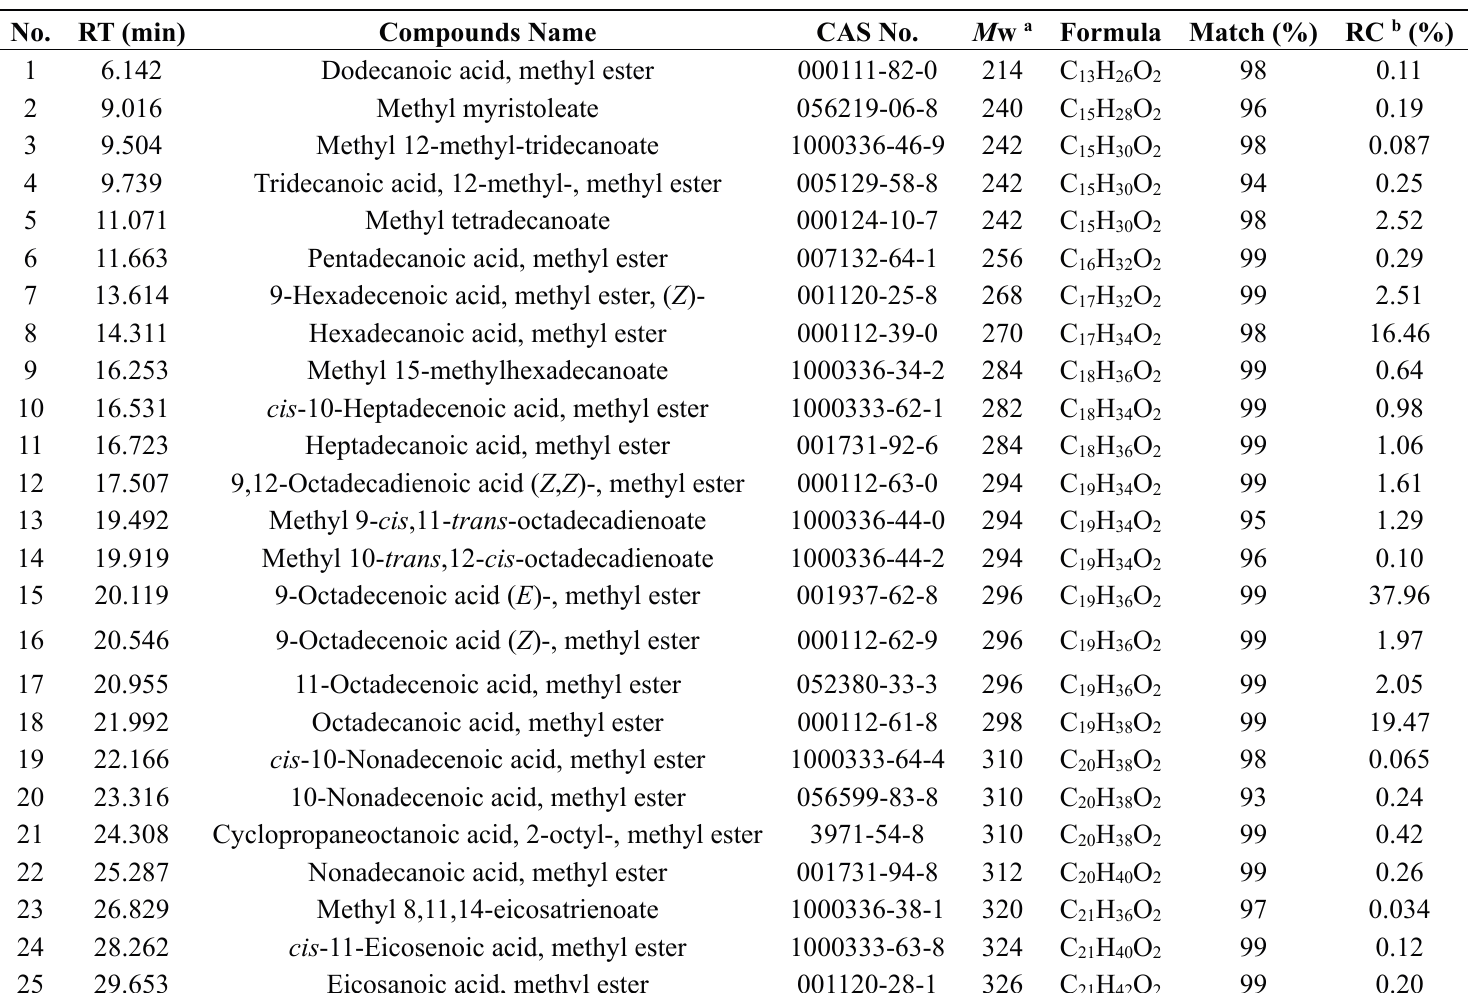
Table 1. Fatty acids identified in SO sample using precolumn